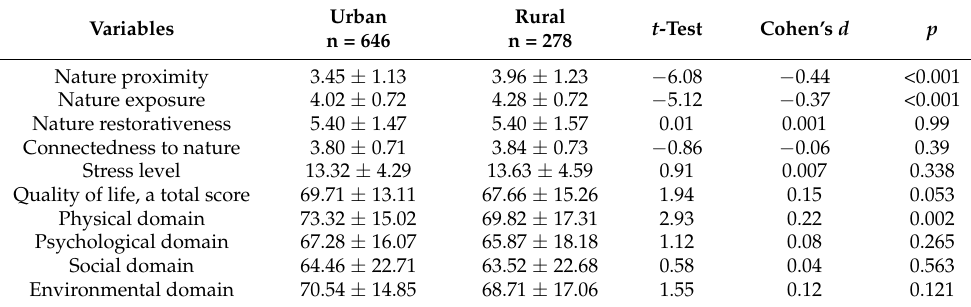
Table 1. Comparison of the study variables (M ± SD) across urban vs. rural place of residence groups (n =